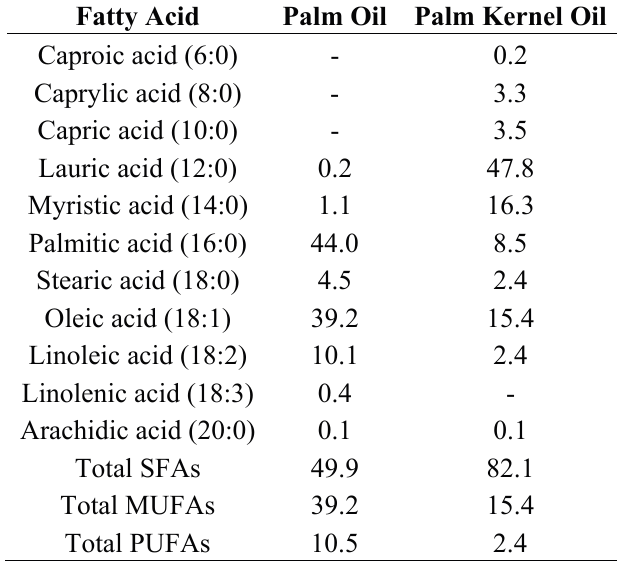
Data partially obtained and adapted from [7]. -: